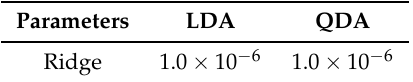
Table 3. LDA and QDA classifier parameters used in this work.